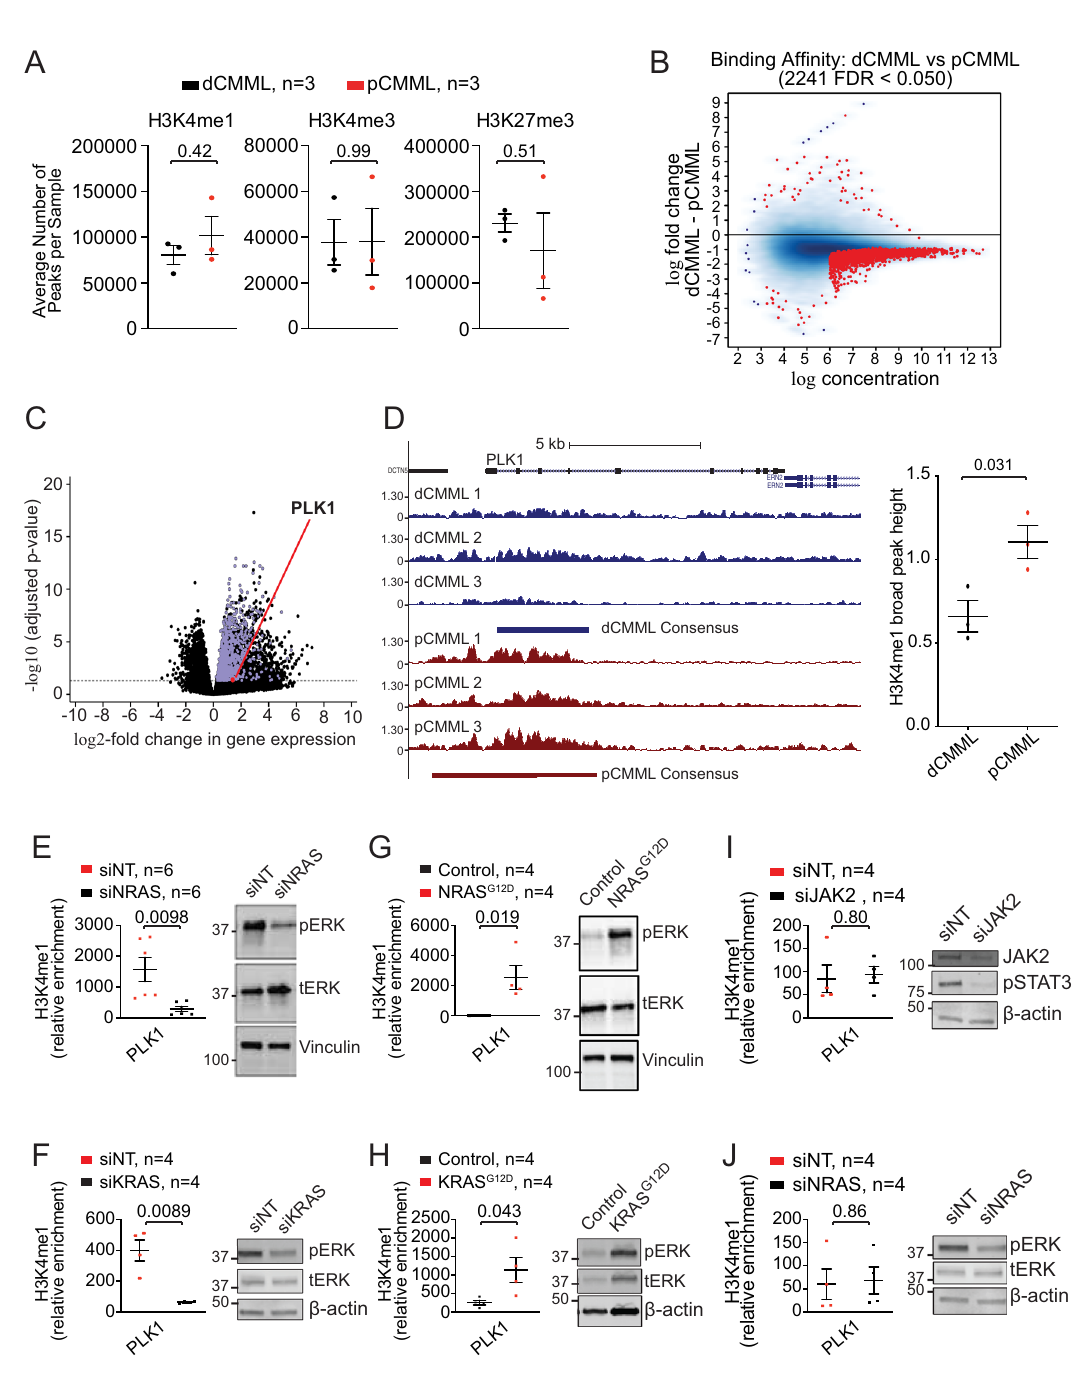
Fig. 4 RAS pathway mutations drive expression of mitotic checkpoint kinase PLK1 . A Unsupervised hierarchical clustering of RNA-seq performed on peripheral blood samples from 35 CMML patients. Cluster 1 (black) with RAS wild-type dCMML cases and Cluster 2 (red) with RAS mutant pCMML cases. B Volcano plot demonstrating differentially upregulated (red) and downregulated (green) genes in RAS mutant pCMML (vs RAS wild-type dCMML) expressed as log2-fold change. Indicated p -values on the y -axis is calculated by the Wald test and false discovery rate-corrected. C Table of most upregulated therapeutically actionable genes in pCMML relative to dCMML. D Quantitative PCR (qPCR) validation of PLK1 expression in patient-derived MNCs from NRAS wild-type (wt) dCMML, NRAS mutant (mt) dCMML, JAK2 mt pCMML, and NRAS mt pCMML cases. E Scatter plot comparing relative PLK1 expression to variant allele frequency (VAF) of NRAS mutation. F qPCR for NRAS and PLK1 in NRAS mutant pCMML MNCs after transfection with non- targeting siRNA (siNT), or siRNA against NRAS (siNRAS). G qPCR for NRAS and PLK1 in NRAS wild-type dCMML patient-derived MNCs after transfection with an empty vector (Control) or NRAS G12D . H qPCR for KRAS and PLK1 in KRAS mutant pCMML MNCs after transfection with siNT or siKRAS. I qPCR for KRAS and PLK1 in KRAS wild-type dCMML MNCs after transfection with an empty vector (Control), or KRAS G12D . Western blots in panels F – I are representative of three experiments. Data in panels D and F – I are presented as mean ± SEM. Indicated p -value in panels D – I by two-tailed Student ’ s t test. The indicated n represents the number of biologic replicates. Source data are provided as a Source Data fi